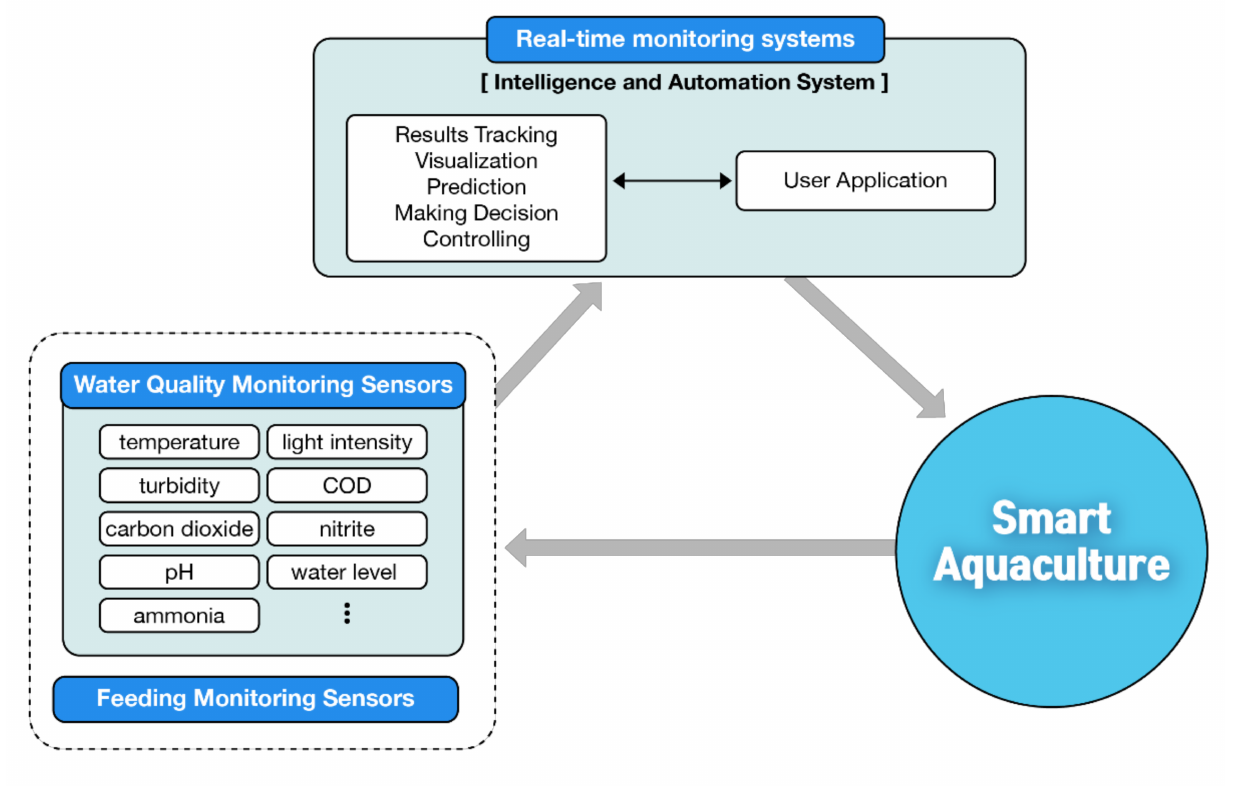
Figure 2. Overview of smart aquaculture sensors and monitoring